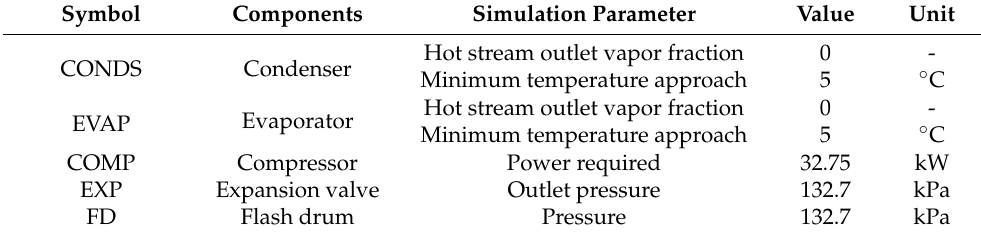
Table 3. Specifications of the heat pump.